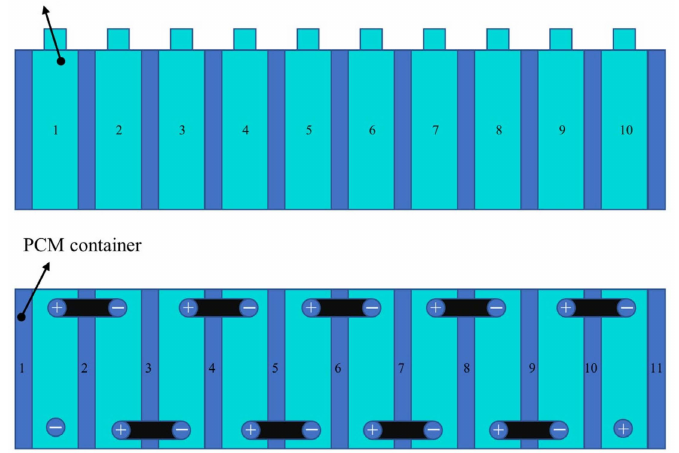
Figure 4. Battery module connection. The numbers in the top figure indicate the battery serial number and the numbers in the bottom figure indicate the PCM container serial